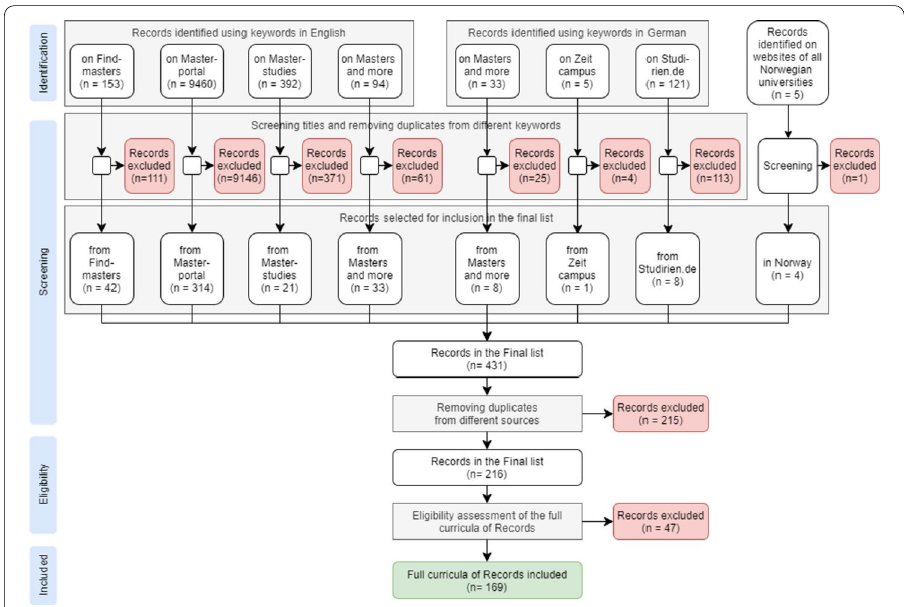
Fig. 1 Systematic search process according to PRISMA statement (Moher et al.,